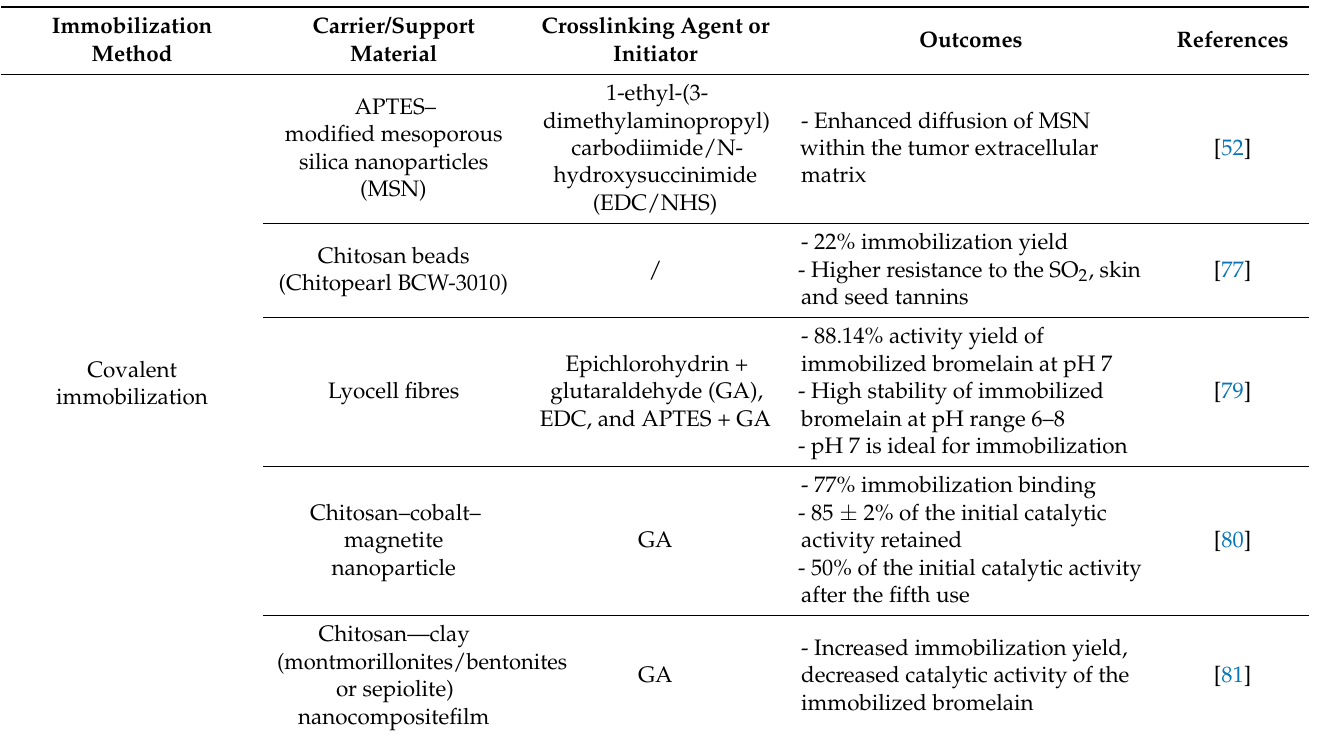
Table 2. Review of bromelain immobilization